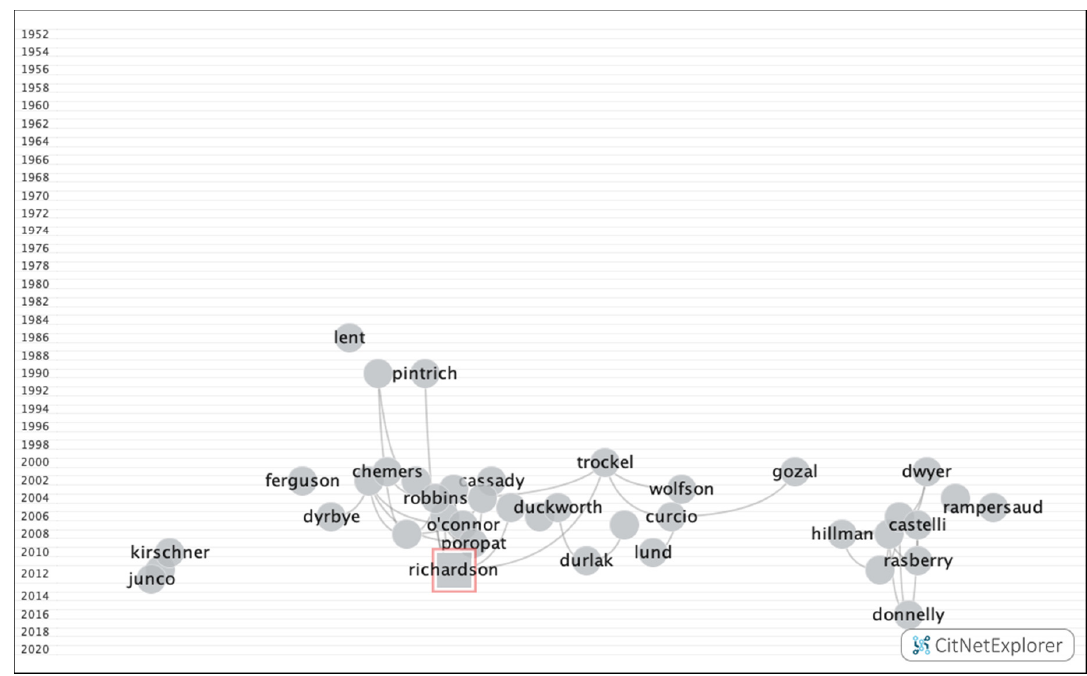
Figure 2. Citation Network of the 20 most cited publications on academic performance. Table 1. Details of the 20 most cited publications on academic performance.